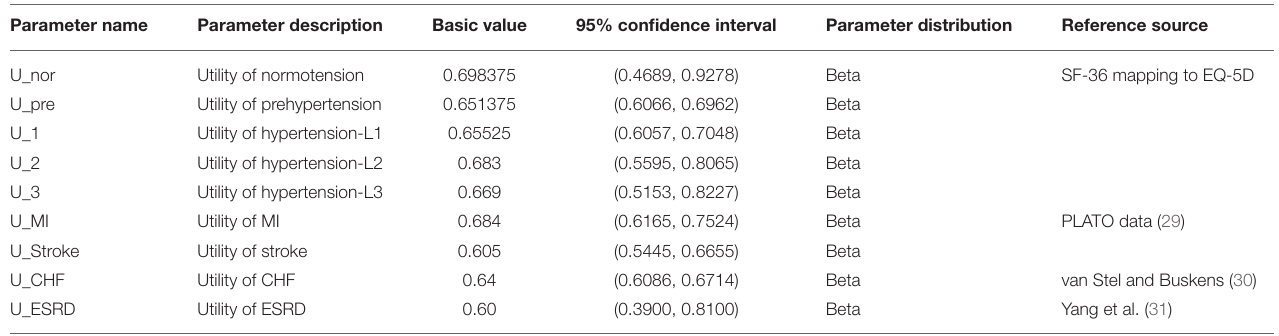
TABLE 2 | Utility, range, parameter distribution, and reference sources for different health